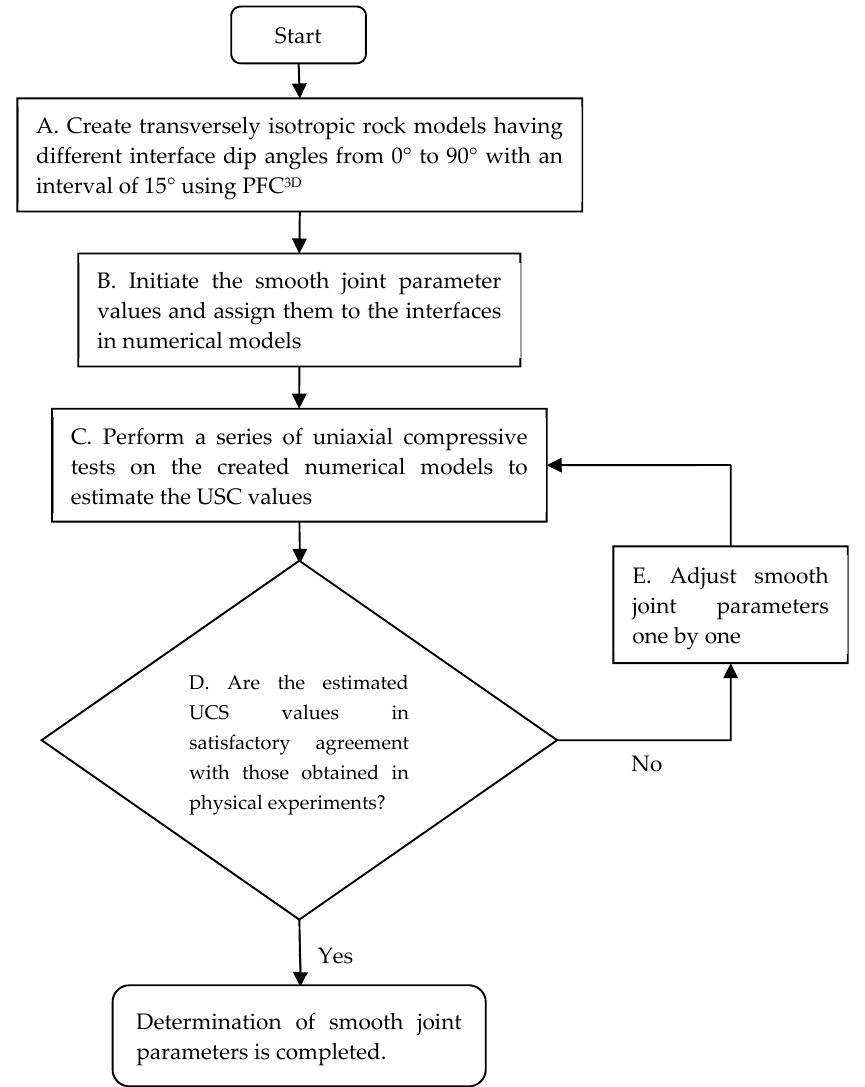
Figure 6. Calibration process for determination of smooth joint parameters.